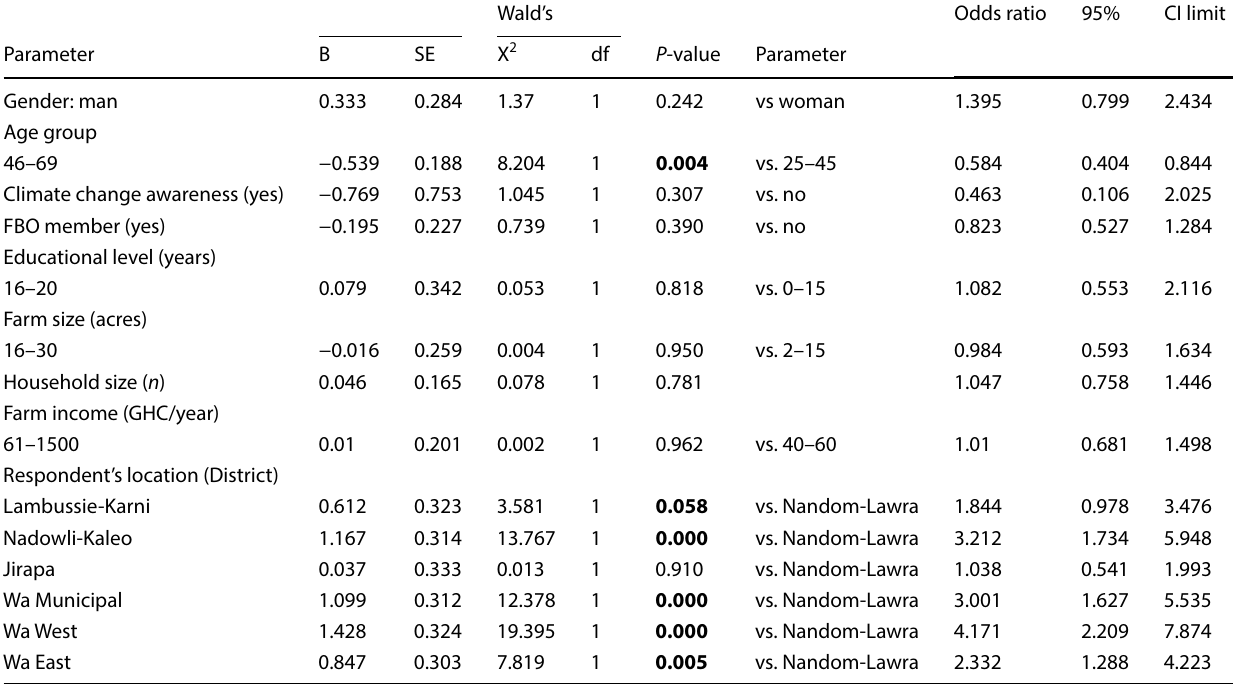
Table 8 Logistic regression estimates (maximum likelihood and odds ratios) for socio-economic data-predicting adaption of early planting time (1) versus none (0)